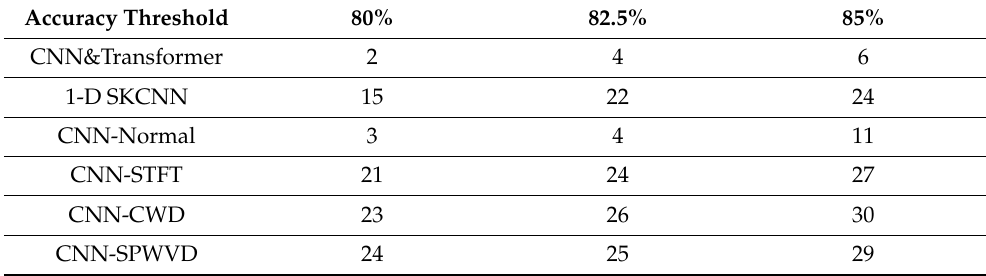
Table 6. The average classification accuracy for 44 types of modulation that is less than 80%, 82.5% and 85%, based on the mentioned models.